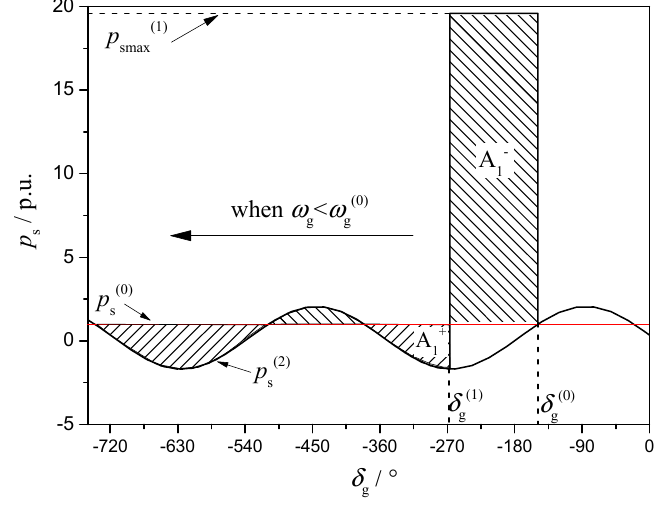
Figure 9. Schematic diagram of the generator electromagnetic power.